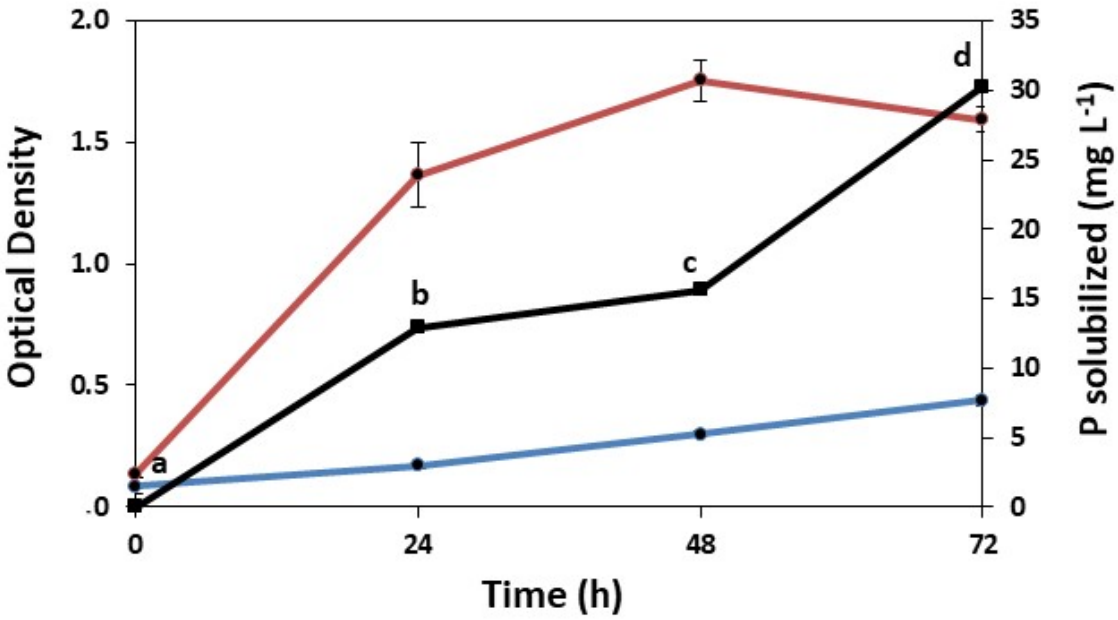
Figure 5. Growth of C. vulgaris in NBRIP medium without insoluble phosphate (blue line) and with insoluble phosphate (red line), along with phosphorus solubilization (black line). Different letters on the black line indicate significant difference determined by Tukey’s test at each time period ( p < 0.05).